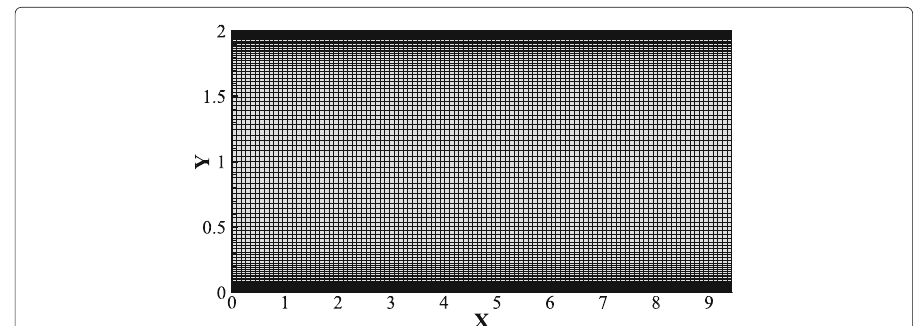
Fig. 2 The grid on X-Y plane for the fully developed turbulent channel